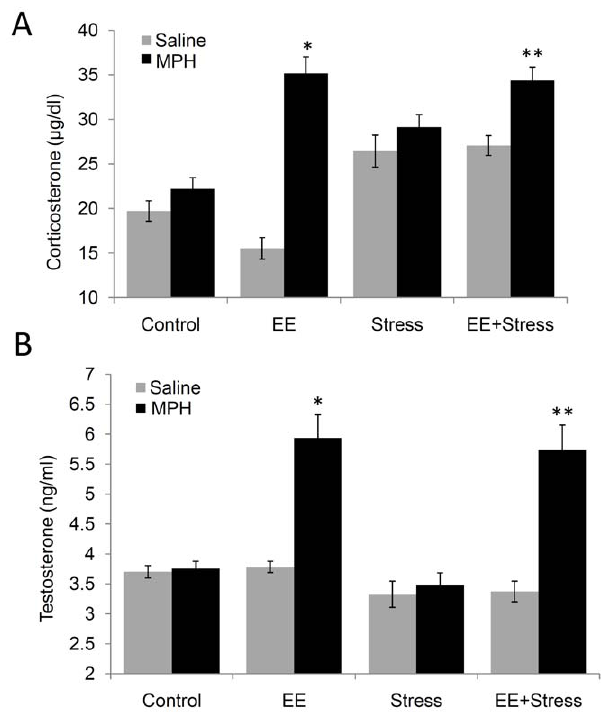
Figure 5. The effect of MPH on CORT and TST levels. A significant difference in CORT (A) and TST (B) levels was observed. MPH treatment significantly increased CORT level in the EE and EES groups (* P , 0.0001; ** P , 0.002 compared with their respective controls). TST level was similar across all groups, while MPH treatment increased TST level in both EE and EES groups (* P , 0.001; ** P , 0.012 compared with their counterpart controls). n=9 to 10 per group.